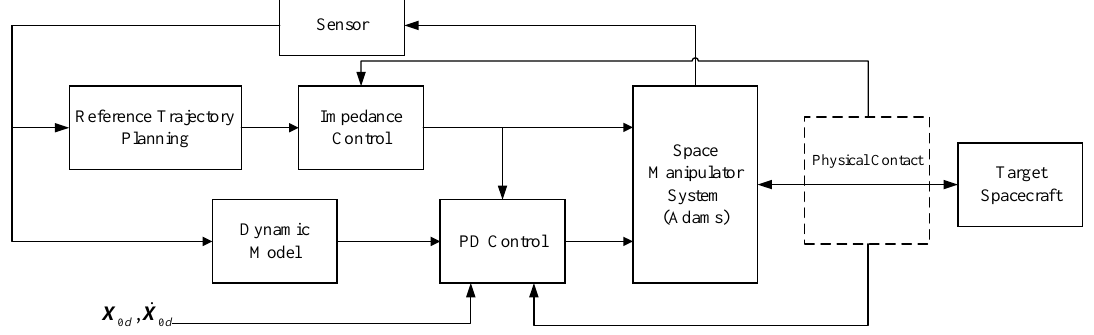
Figure 4. Schematic of the closed-loop PD-impedance combined control system.